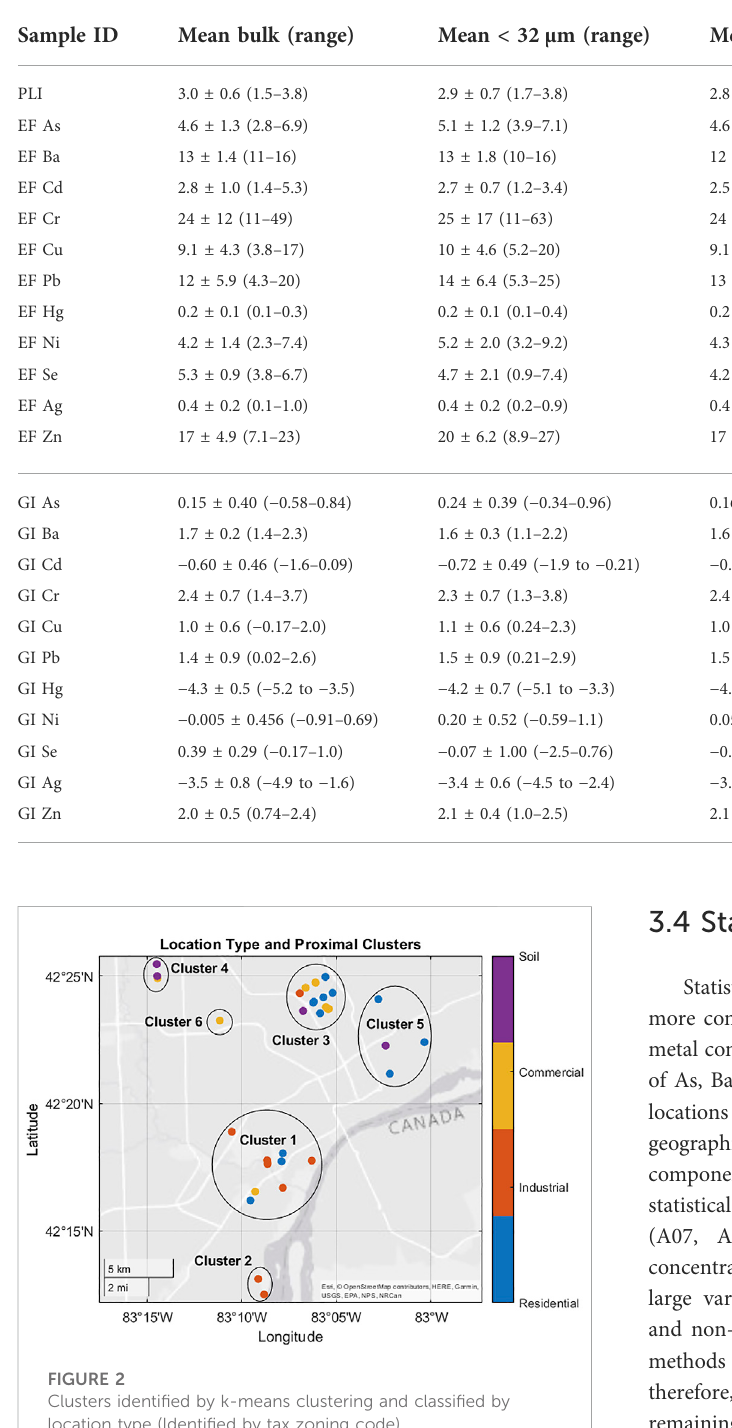
TABLE 2 Comparison of Pollution Load Index (PLI), geoaccumulation index (GI), and enrichment factor (EF) in bulk and size fractions.